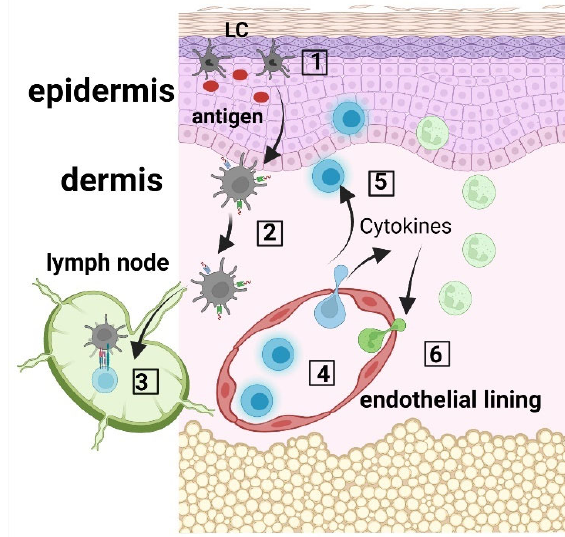
Figure 1. LC immune network. ( 1 ) Langerhans cells (LCs) within the epidermis take up antigen; ( 2 ) LCs internalize and process the antigen, and present the produced peptides on their surface via MHC molecules; ( 3 ) LCs migrate to the skin draining lymph nodes where they prime CD45RA + naïve T cells; ( 4 ) Activated T cells migrate to the skin, where they produce cytokines and chemokines ( 5 ), which recruit innate immune cells, including neutrophils from the blood circulation ( 6 ).